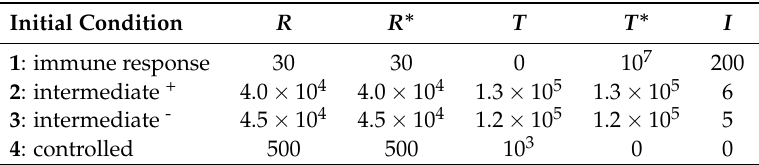
Table 2. Initial conditions for the time evolutions. Note that the initial condition 2 has higher T cell concentrations and lower Tregs concentrations than the initial condition